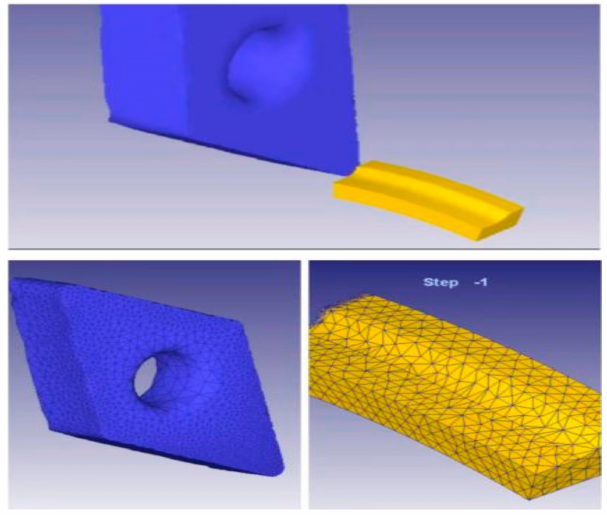
Figure 2. Turning